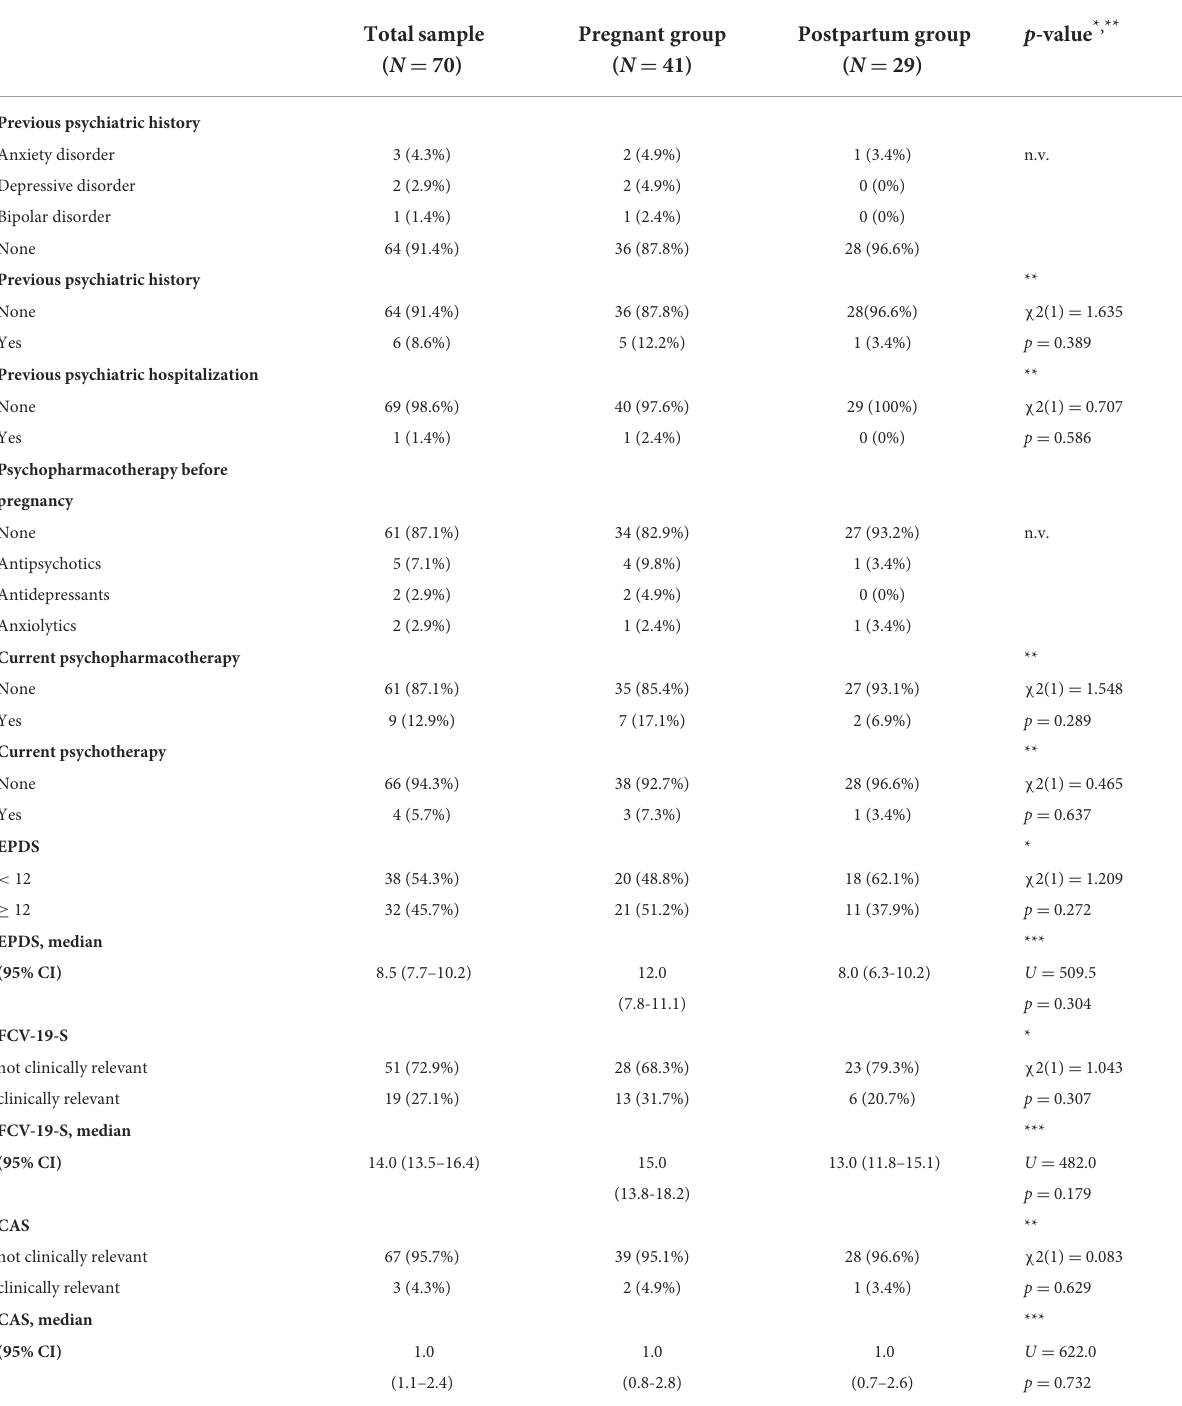
TABLE 3 Clinical and psychopharmacological characteristics of the sample.